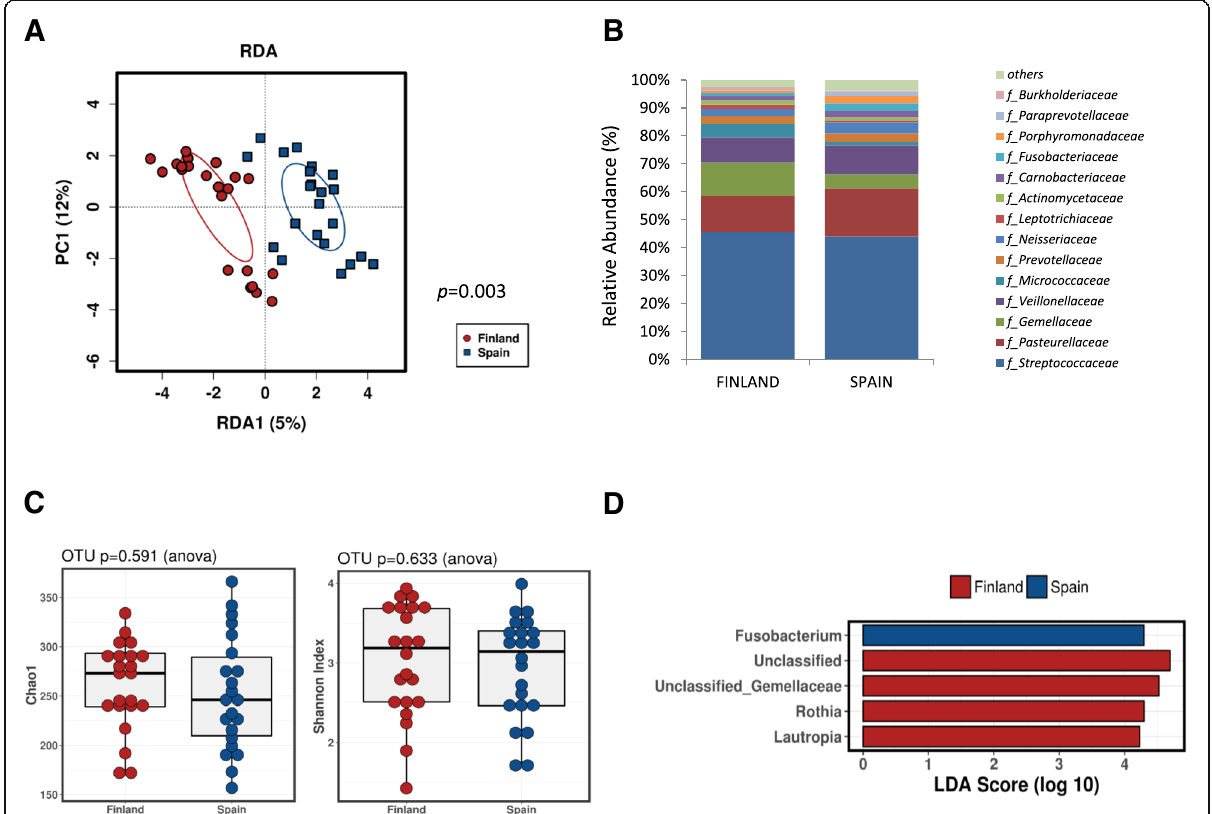
Fig. 1 Geographical location impact on the oral microbiome. a Multivariate redundant discriminant analysis (RDA) plot based on microbiota data at OTU level between countries (Finland vs Spain) and 95% confidence ellipse for each country. b Relative abundances (%) at family levels in each country. c Alpha-diversity measured by Chao 1 index (richness) and Shannon index (diversity). Samples have been rarefied to read depth of 2103 sequences. d Linear discriminant analysis Effect Size (LEfSe) at genus level, showing the genus which most likely explain differences between